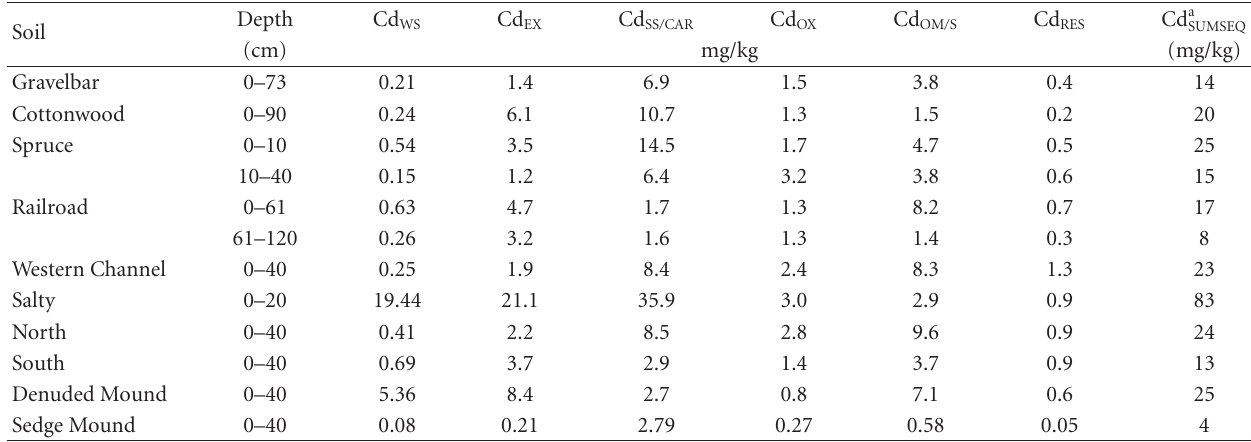
Table 11: Sequential fractionation of Cd in study pedons.